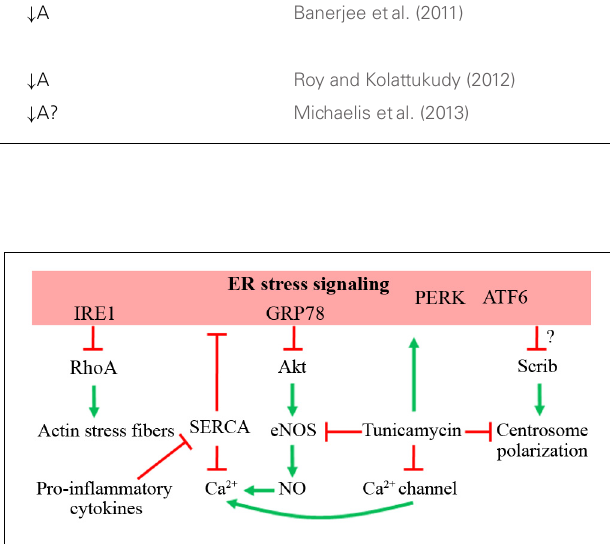
FIGURE 2 | Possible role of ER stress on EC migration. The effects of ER stress signaling on different proteins that command cellular migration is depicted, as well as the effect of tunicamycin, an ER stress inducer. Red lines indicate inhibition or down-regulation of the target. Green arrows indicate activation or up-regulation of the